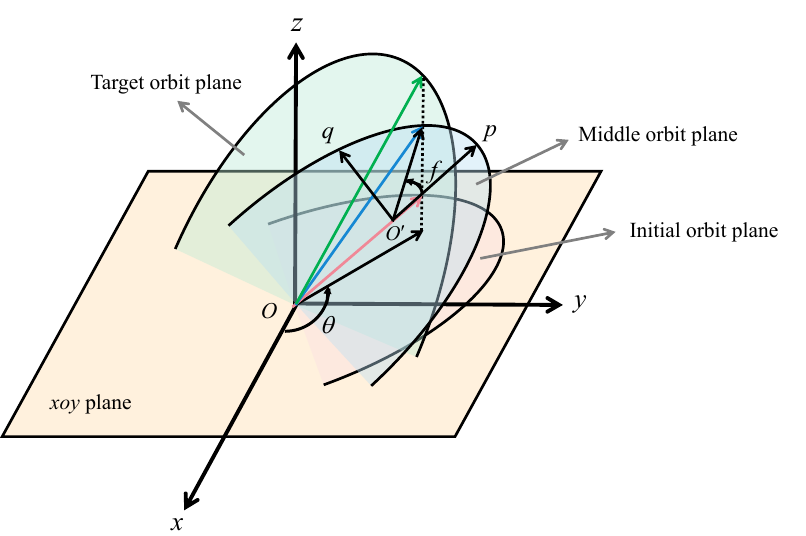
Figure 2. Diagram of the relationship between f and θ